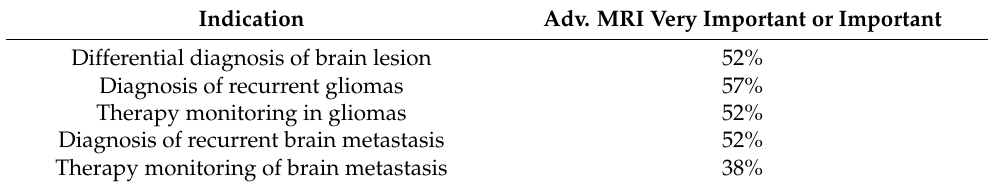
Table 3. Rating of the significance of advanced MR procedures (PWI, MRS, and DWI) for different indications compared to FET PET.